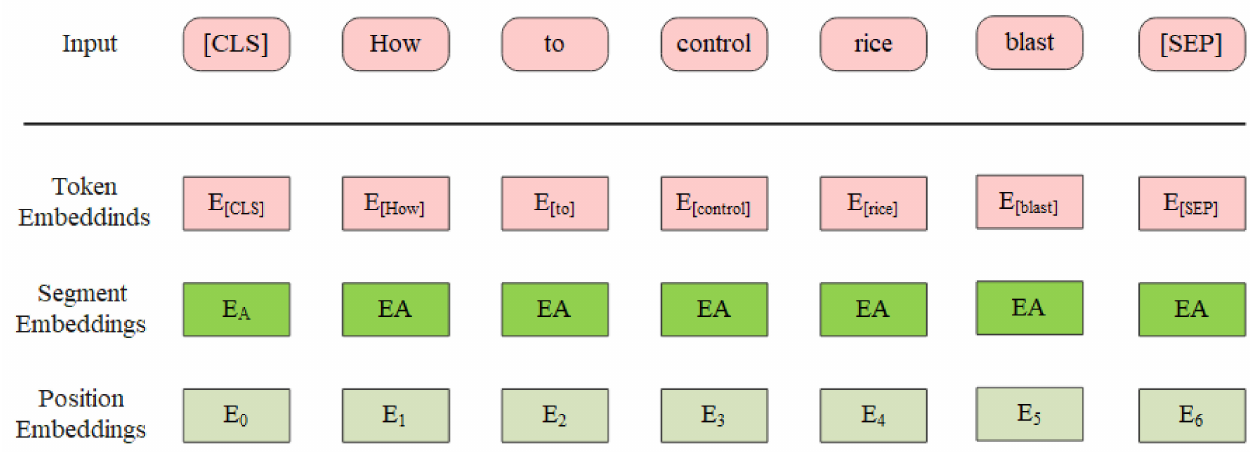
Figure 3. Bert input